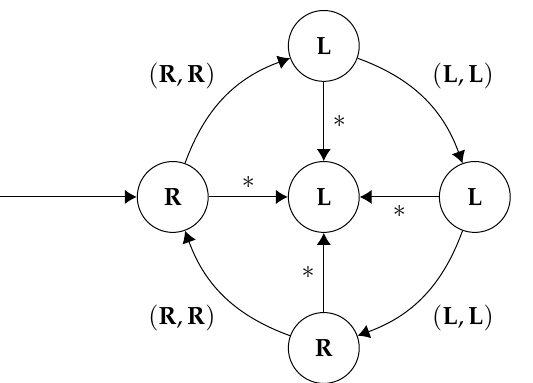
Figure 4. A finite memory strategy for player 2 which forms part of a Nash equilibrium which models the given specification. The asterisks * are wildcards—they match any action which isn’t explicitly detailed on the